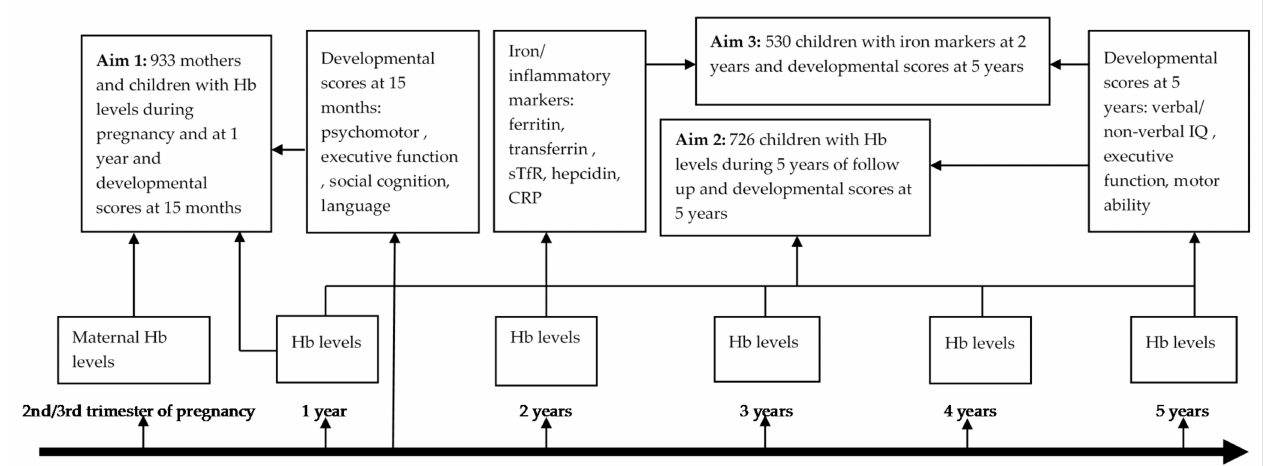
Figure 1. Study design. CRP, C-reactive protein; Hb, hemoglobin levels; sTfR, soluble transferrin